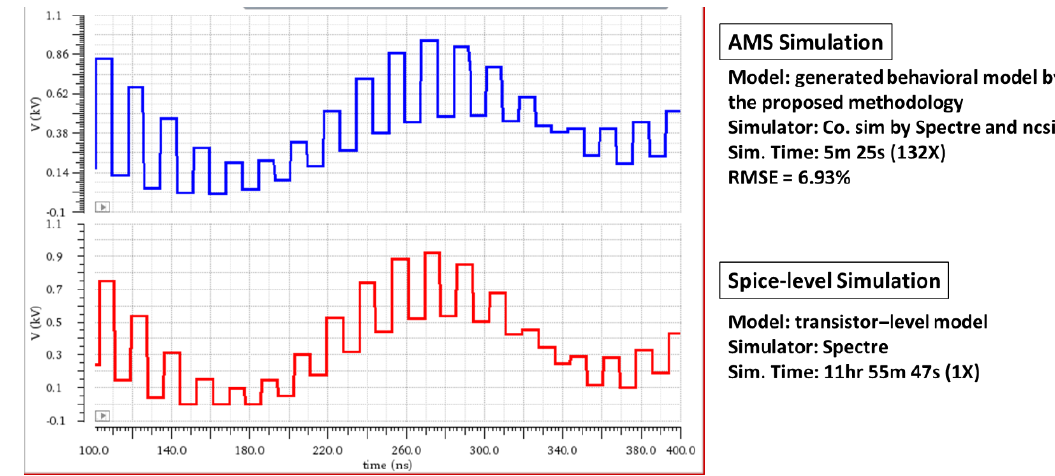
Figure 17. Simulation waveforms of the VDADC (Voltage Differential Analog-to-Digital Converter) design.